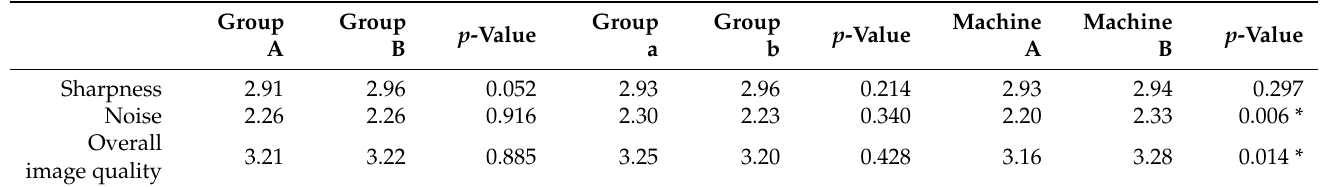
Table 3. Results of qualitative image analysis according to parameters.